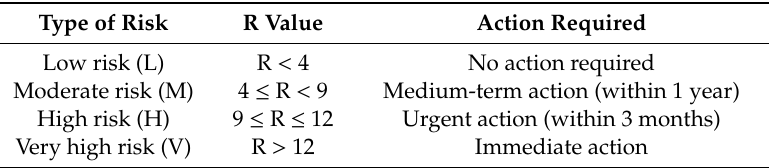
Table A4. Risk categories (risk rating).